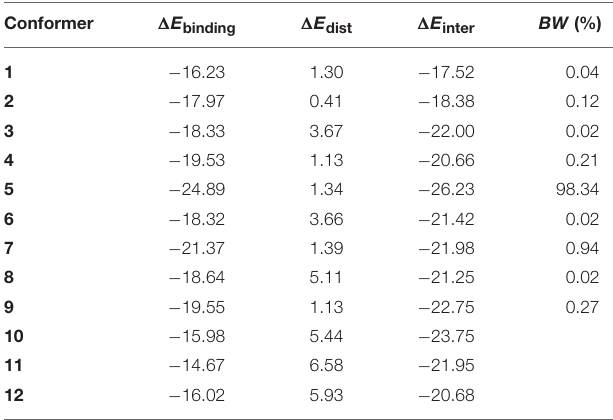
TABLE 5 | Dispersion contribution to binding 1 E disp,binding and interaction 1 E dist,inter energies, intermolecular CT of ground q the 12 conformers (energies in kcal/mol, charge in |e|) a .